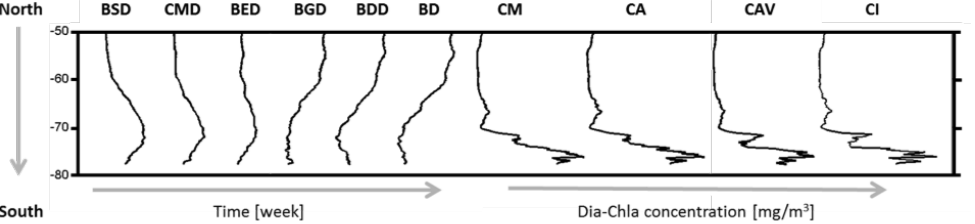
Figure 6. Schematic representation of the latitudinal variability (longitudinal average) of the phenological indices: bloom start date (BSD), date of Dia-Chla maximum (CMD), bloom end date (BED), bloom growth duration (BGD), bloom decline duration (BDD), bloom duration (BD), Dia-Chla maximum (CM), Dia-Chla amplitude (CA), Dia-Chla averaged BGD (CAV), Dia-Chla integrated over BGD